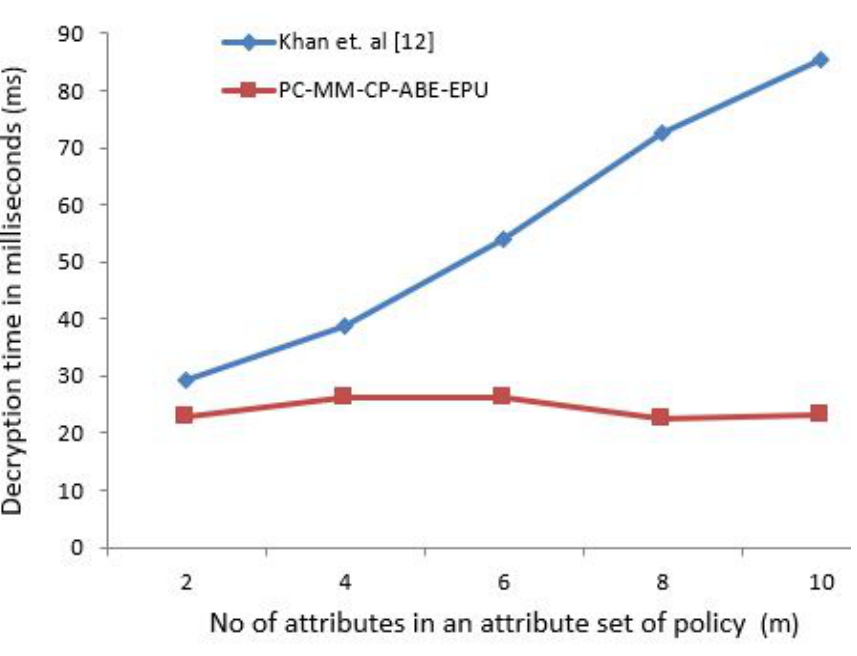
Figure 4. Contextual User’s Conforming Policy for data access.